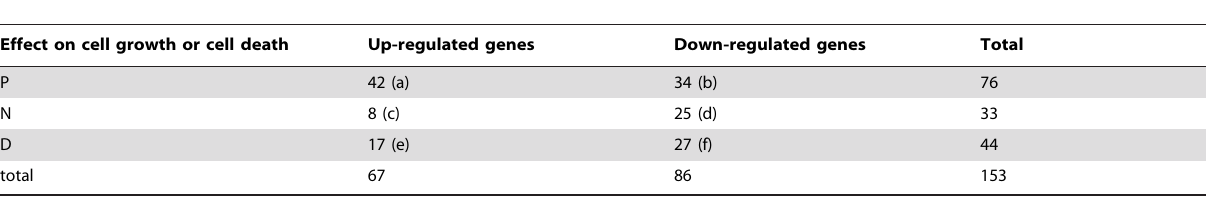
Table 1. Effect miR-181b induced genes on cell growth and cell